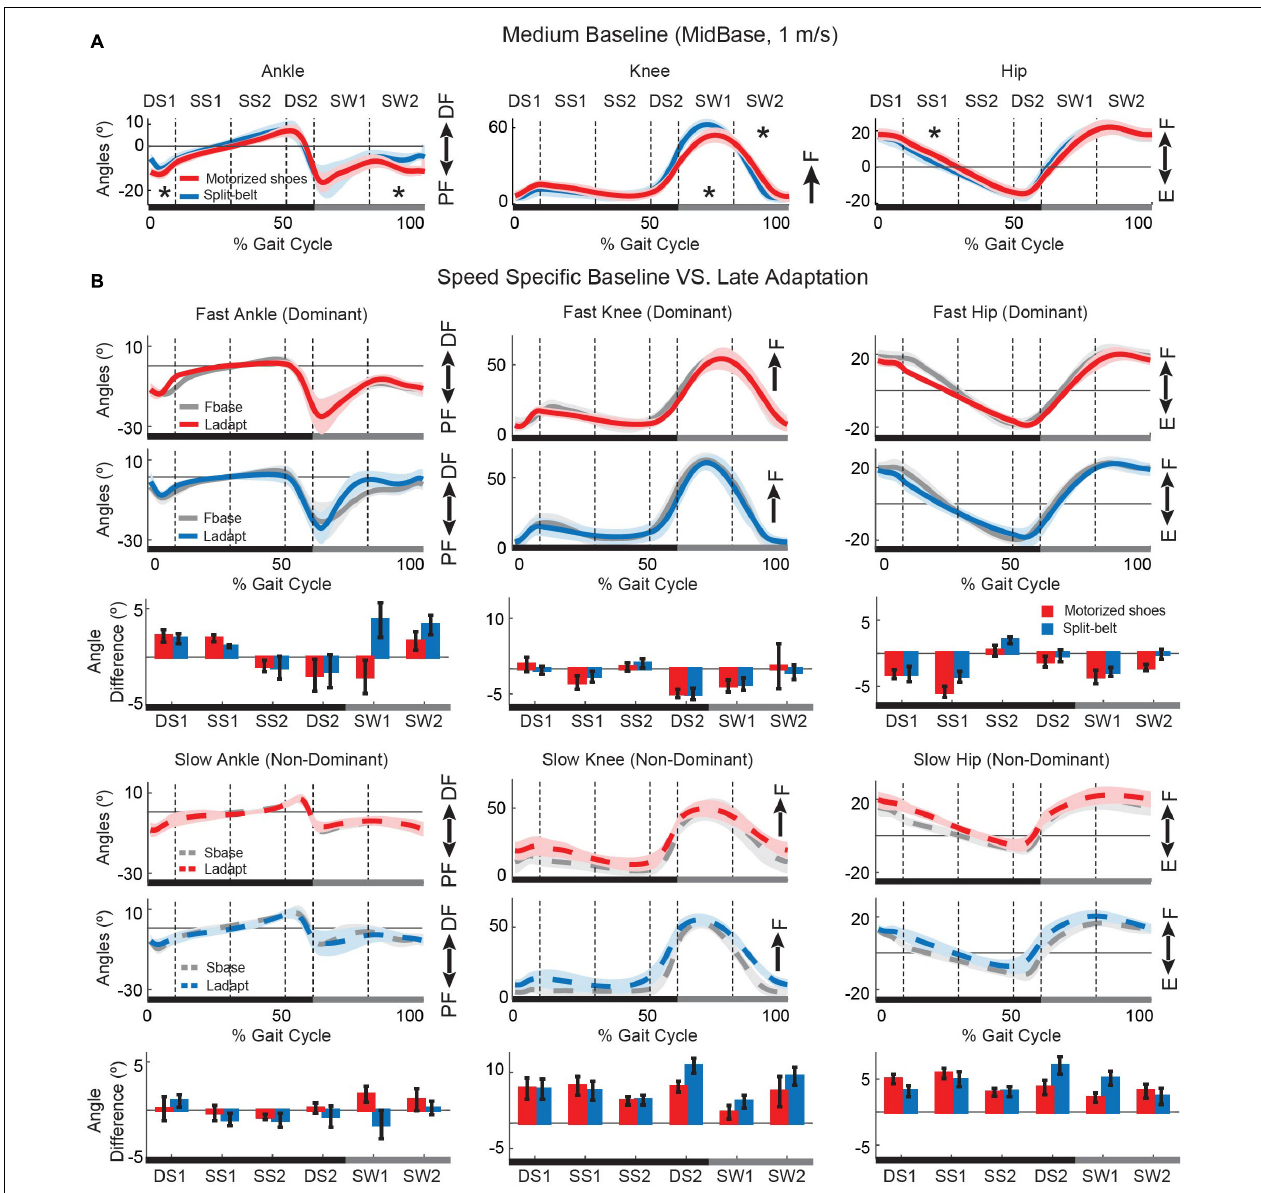
FIGURE 6 | Joint angles over the gait cycle during baseline and adaptation. (A) Baseline joint angles are shown for the group walking with regular sneakers (i.e. blue trace) and the group walking with the motorized shoes (i.e. red trace). Solid lines represent the group average and shaded areas represent standard errors. Asterisks indicate instances during the gait cycle when joint angles were significantly different across groups. The overall motion for all joints was similar across groups, but hip flexion, knee flexion, and ankle dorsiflexion were smaller when wearing the motorized shoes. (B) Speed specific baseline (gray) and steady-state angle trajectories during adaptation for the motorized shoes (red) and the split-belt (blue) groups. Solid lines represent the motion of the leg walking fast in the split condition (colored lines) and in the fast baseline (gray) condition. The dashed lines represent the motion of the leg walking slow in the split condition (colored lines) and in the slow baseline (gray) condition. The bars represent the change from the speed-specific baseline to late adaptation in joint angles during different phases of the gait cycle. DS, double support; SS, single stance; SW, swing; DF, dorsiflexion; PF, plantarflexion; F, flexion; E,